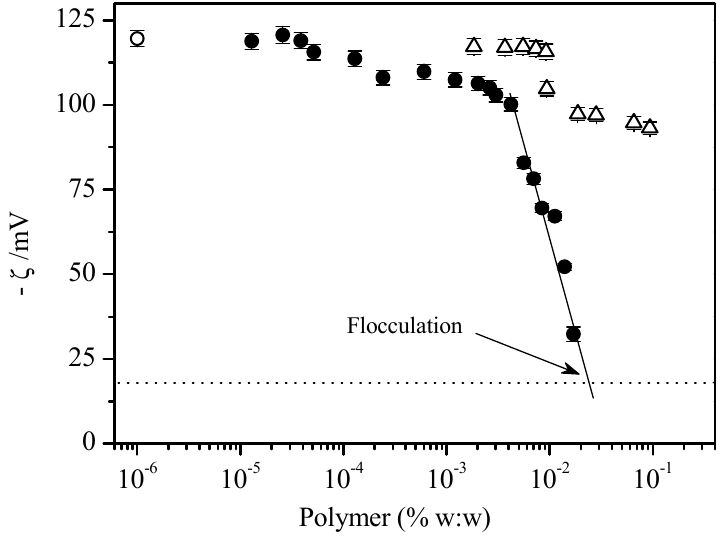
Figure 4. ζ -potential values for vesicles prepared with 0.03 M Aerosol OT and different polymer concentrations. Solid circles represent results for PA/Aerosol OT vesicles and triangles for PMAO/Aerosol OT mixtures. The ζ -potential of Aerosol OT vesicles is represented as the open circle. The dotted line shows the limit ζ -potential value for stable vesicles, see text. The solid line is a visual guide of the